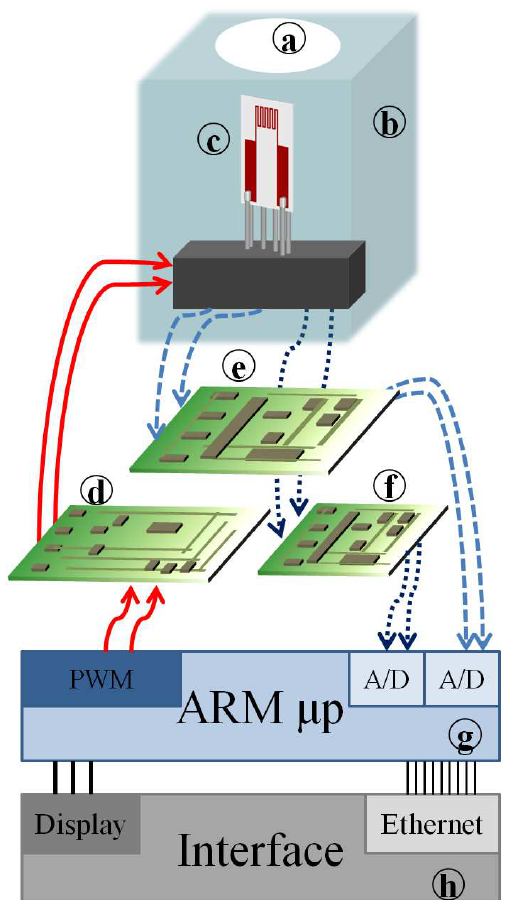
Figure 7. Portable system structure for industrial use. ( a ) Opening; ( b ) enclosure of chemical sampling; ( c ) sensor; ( d ) eater driver; ( e ) R-Vconverter (large range); ( f ) R-V converter (low range); ( g ) µ -processor ARM; ( h )